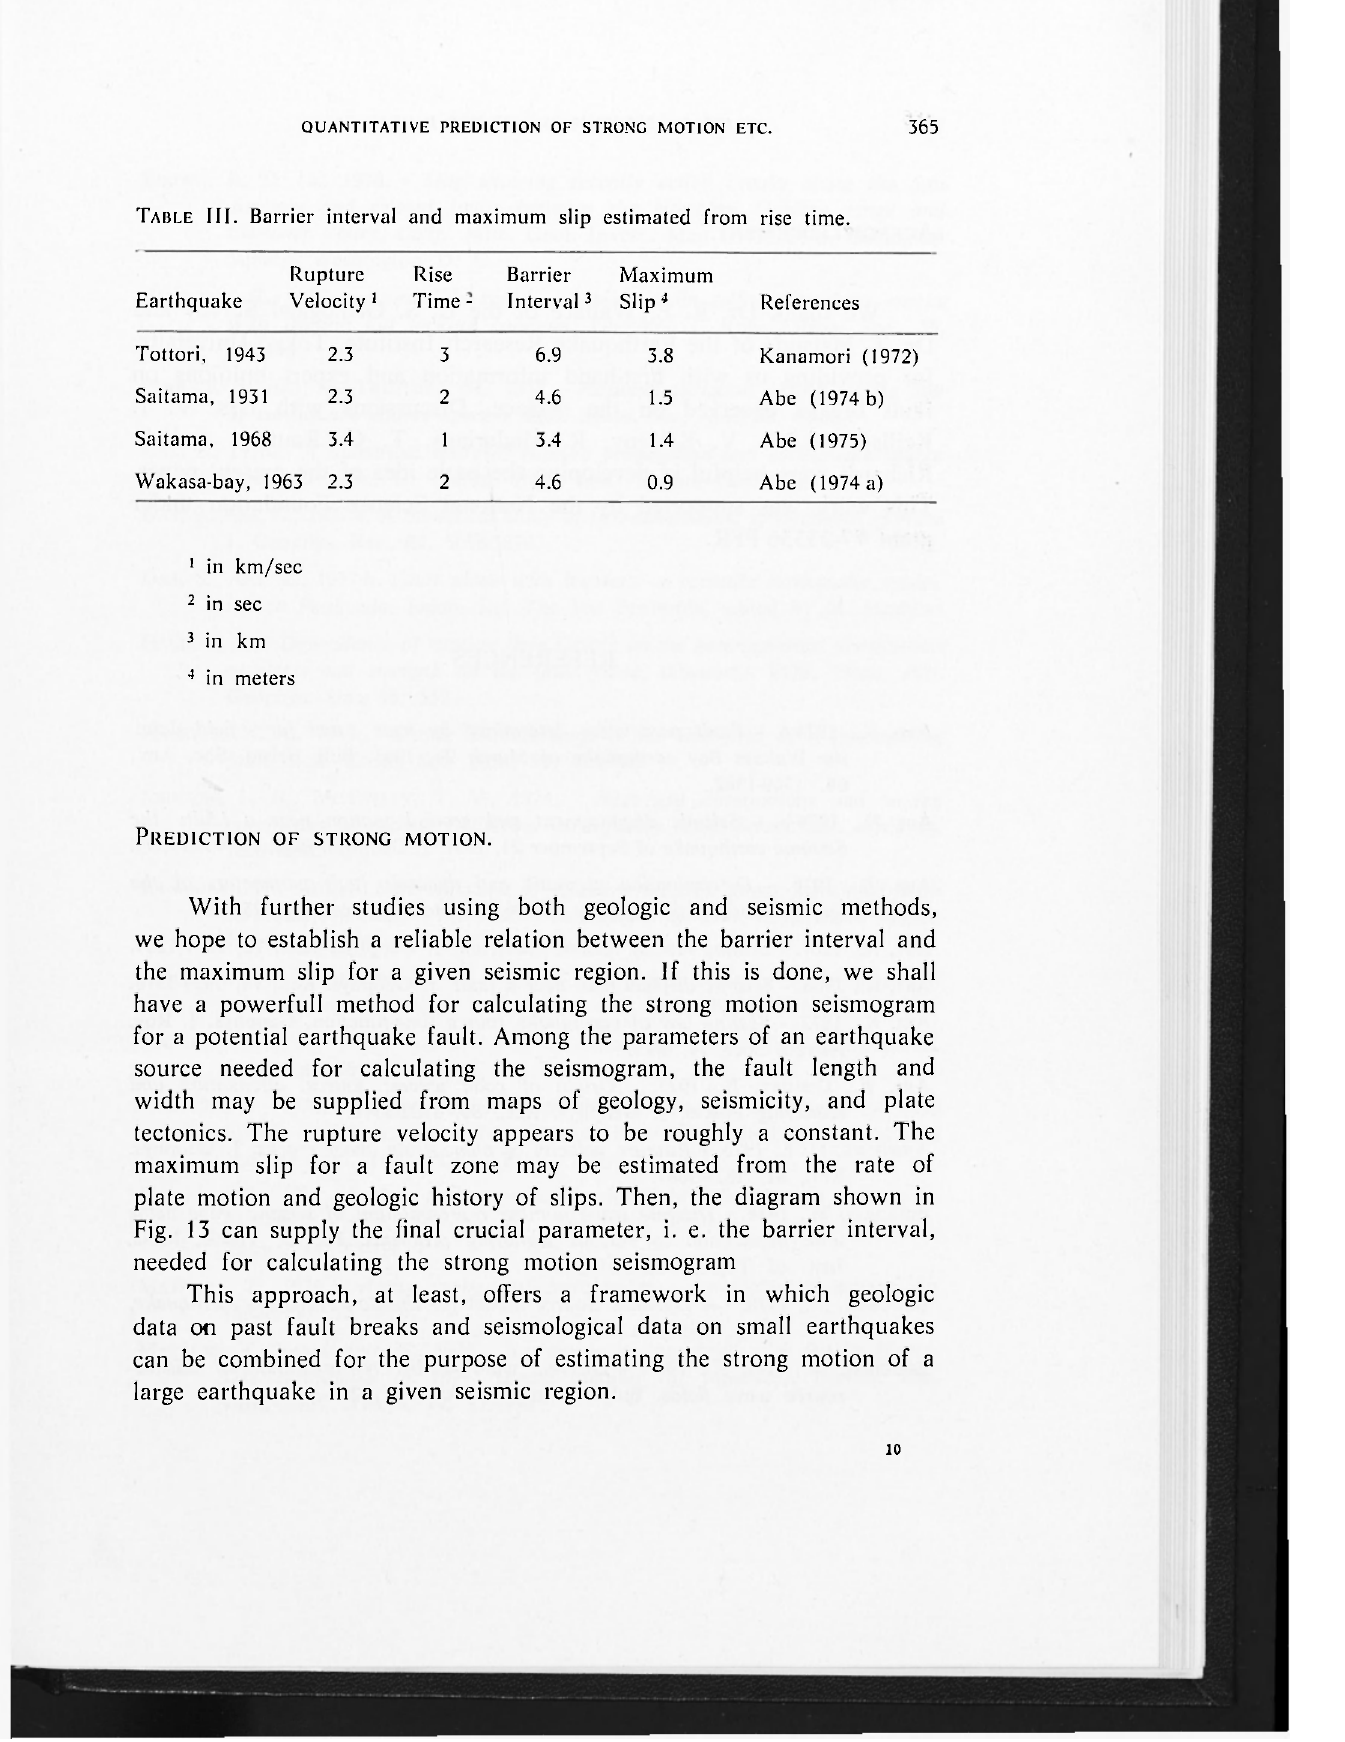
TABLE III. Barrier interval and maximum slip estimated from rise time. Rupture Rise Barrier Maximum Earthquake Velocity 1 Time - Interval 3 Slip 4 Tottori, Kanamori (1972) Saitama,